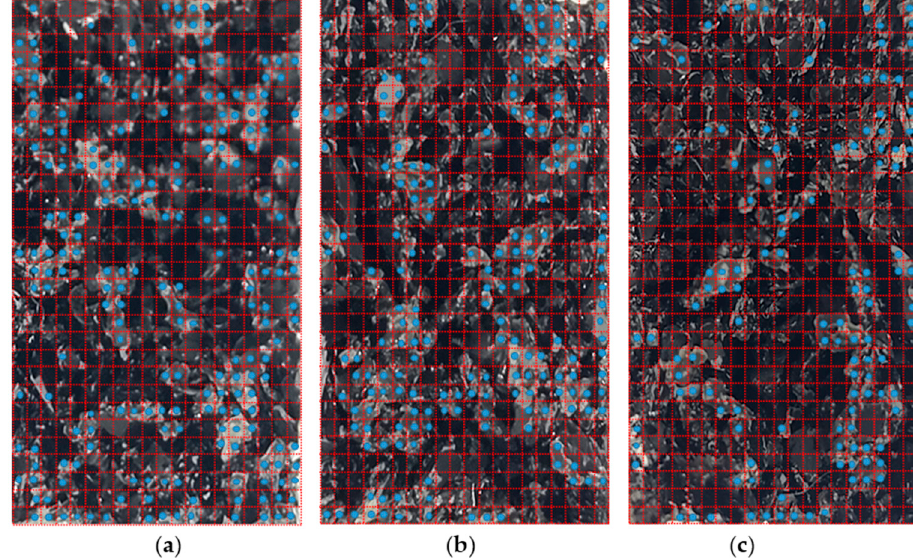
Figure 9. Failure surfaces of elastic rubber layers after the direct tensile test: Curing at ( a ) − 10 ± 2 °C, ( b ) 20 ± 2 °C, and ( c ) 50 ± 2 °C.